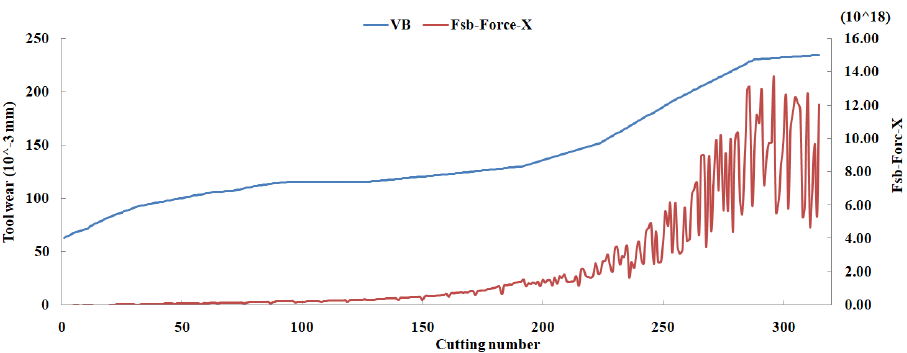
Figure 9. The scatter diagram between F cf in X-dimension Force and tool wear value.